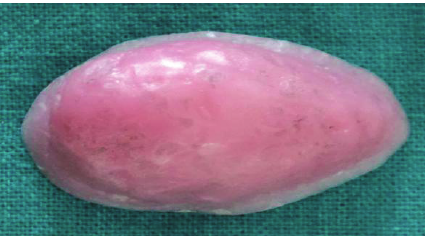
Figure 6: Flasking of waxed-up bulb.